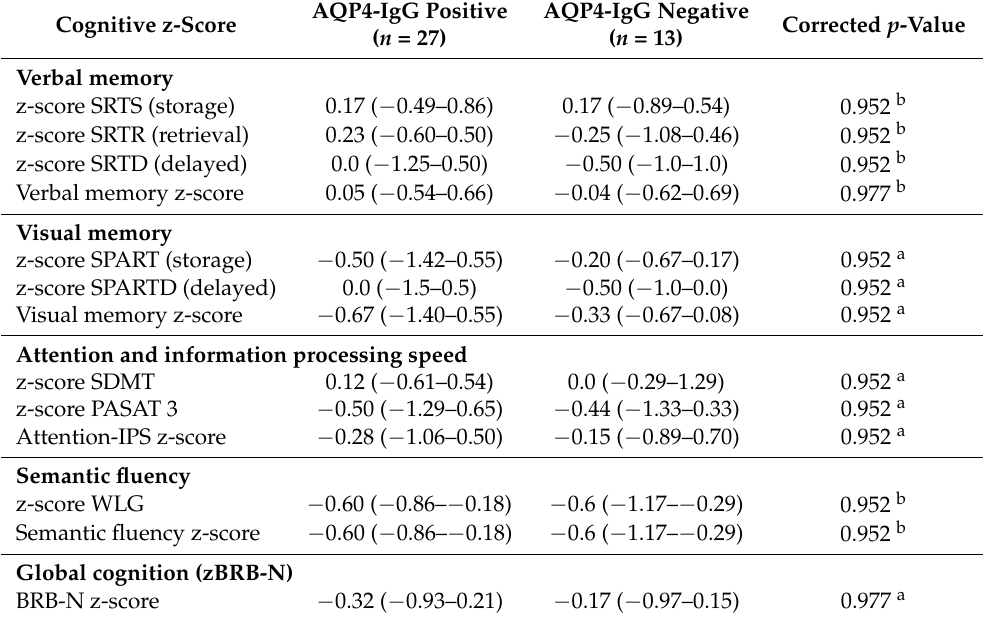
Table 2. Cognitive performance differences between AQP4-IgG-positive and -negative